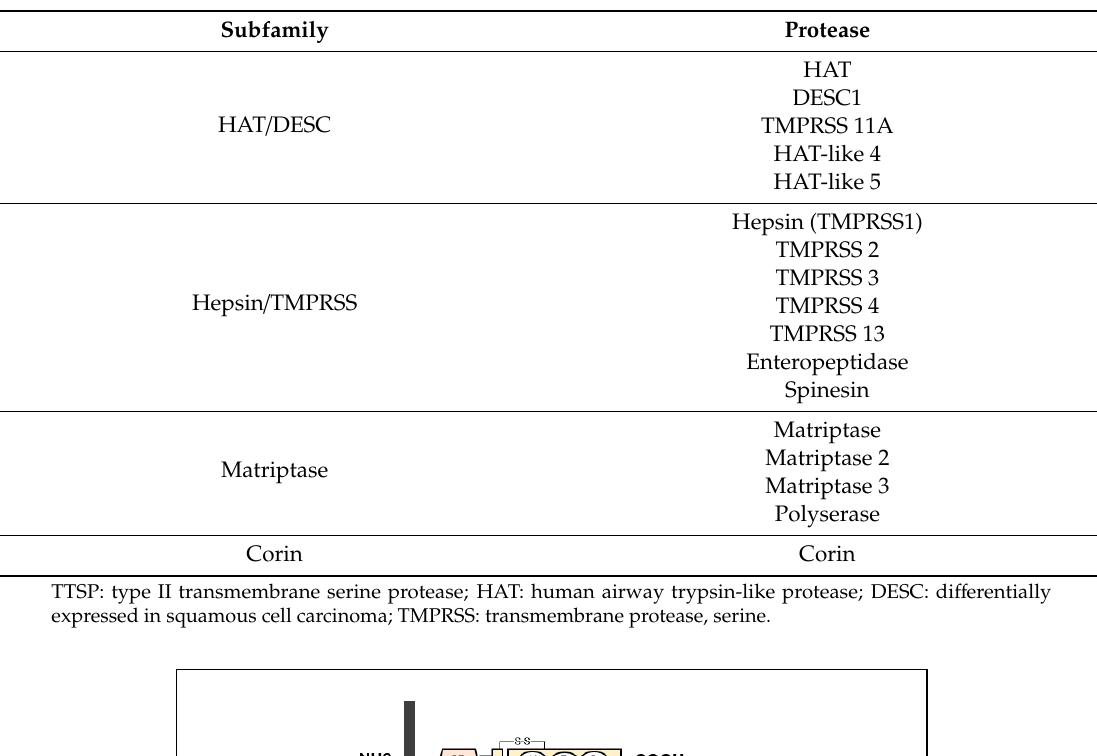
Table 1. T ype II transmembrane serine protease (TTSP) family content. Table 1. Type II transmembrane serine protease (TTSP) family content.